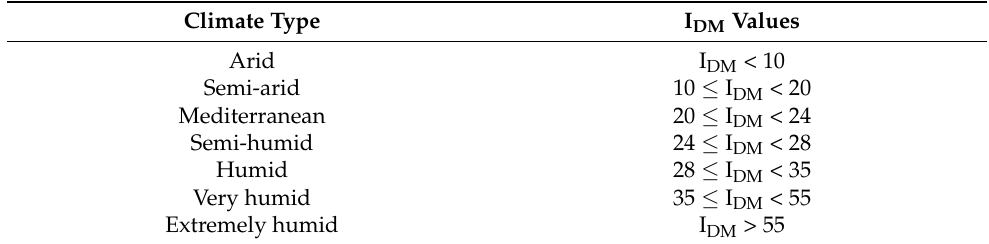
Table 2. Type of climate according to the de Martonne aridity index (I DM